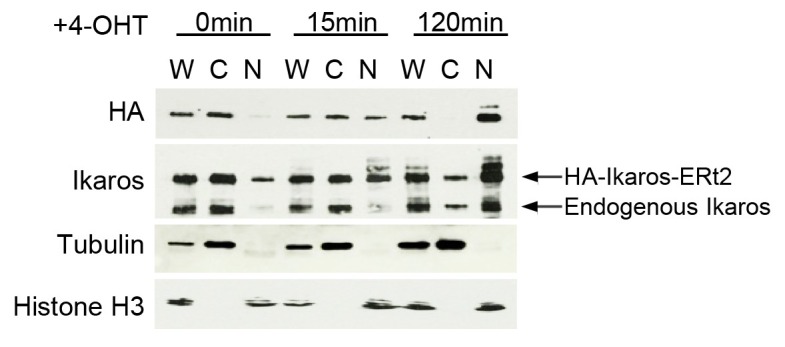
Endogenous versus exogenous Ikaros expression.Western blotting for exogenous Ikaros (anti-HA), total Ikaros (Ikaros C-terminal antibody), the cytoplasmic marker Tubulin and the nuclear marker histone H3 in whole cell lysate (W), cytoplasmic (C) and nuclear (N) fractions before and after 4-OHT addition. Mobility distinguishes endogenous Ikaros from the HA-Ikaros-ERt2 fusion protein.